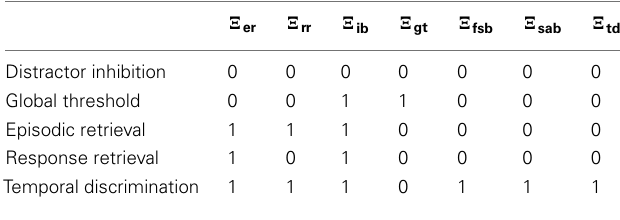
FIGURE 6 |Activation traces over time in the different layers of the GMNP in the voicekey paradigm described in Section 2.2. Different colors correspond to different variables in the respective layer. A few traces are to be highlighted: solid blue lines in both the semantic and the action layer correspond to the respective threshold variable, black in the episodic memory